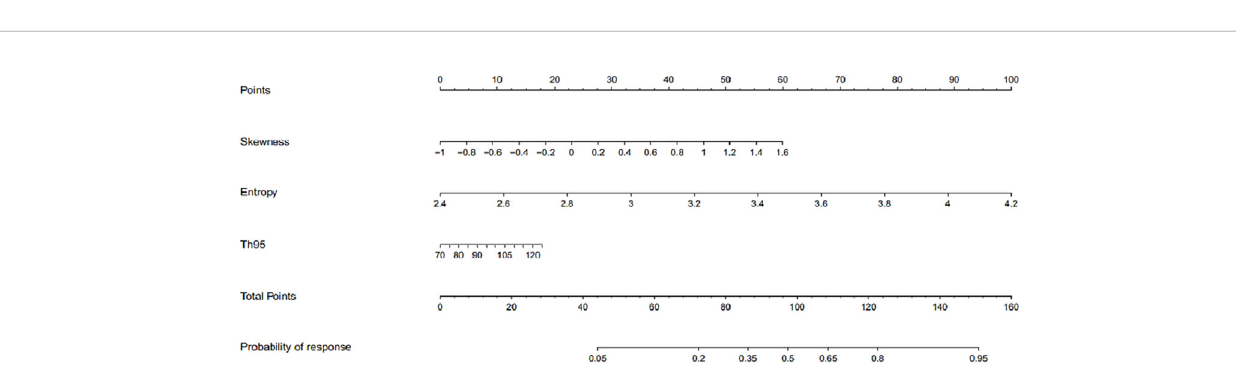
FIGURE 3 | Forest plot of each predictor. The left column lists the names of the predictors. The odds ratio for each of these studies is represented by a square, and con fi dence intervals are represented by horizontal lines. CI, con fi dence interval; OR, odds ratio.